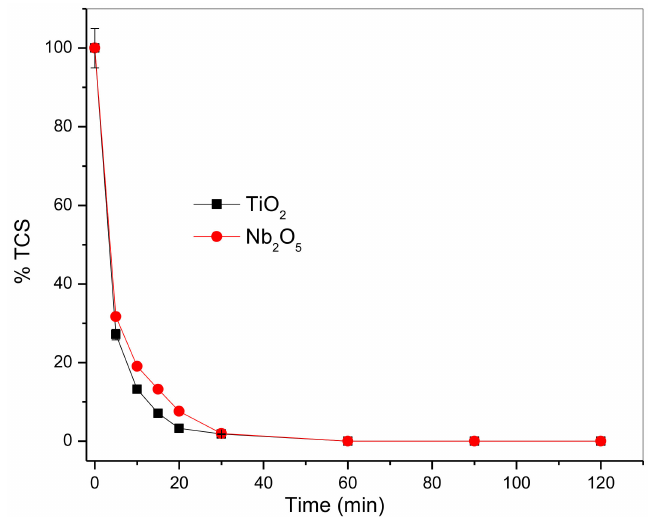
Figure 3. Influence of photo-catalysts using TiO 2 and Nb 2 O 5 (calcined at 773K).